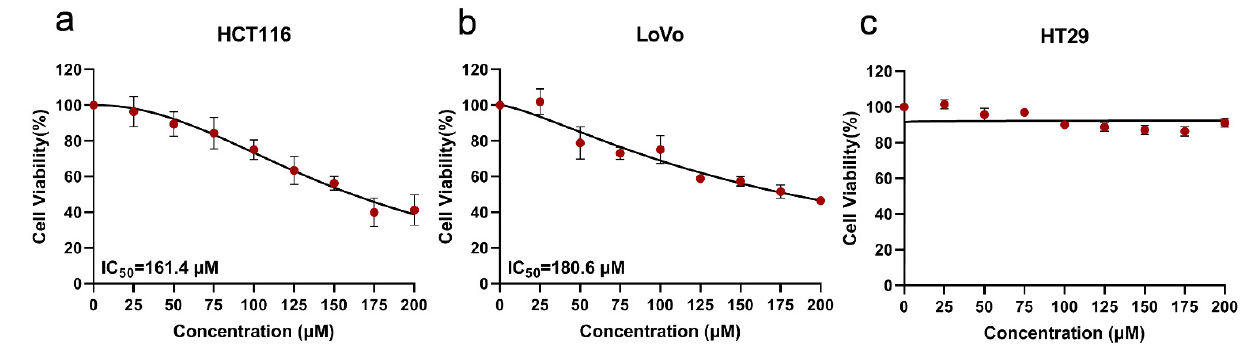
Figure 1. ( a – c ) The effect of SsI on colon cancer cell lines HCT116 ( a ), LoVo ( b ), and HT29 ( c